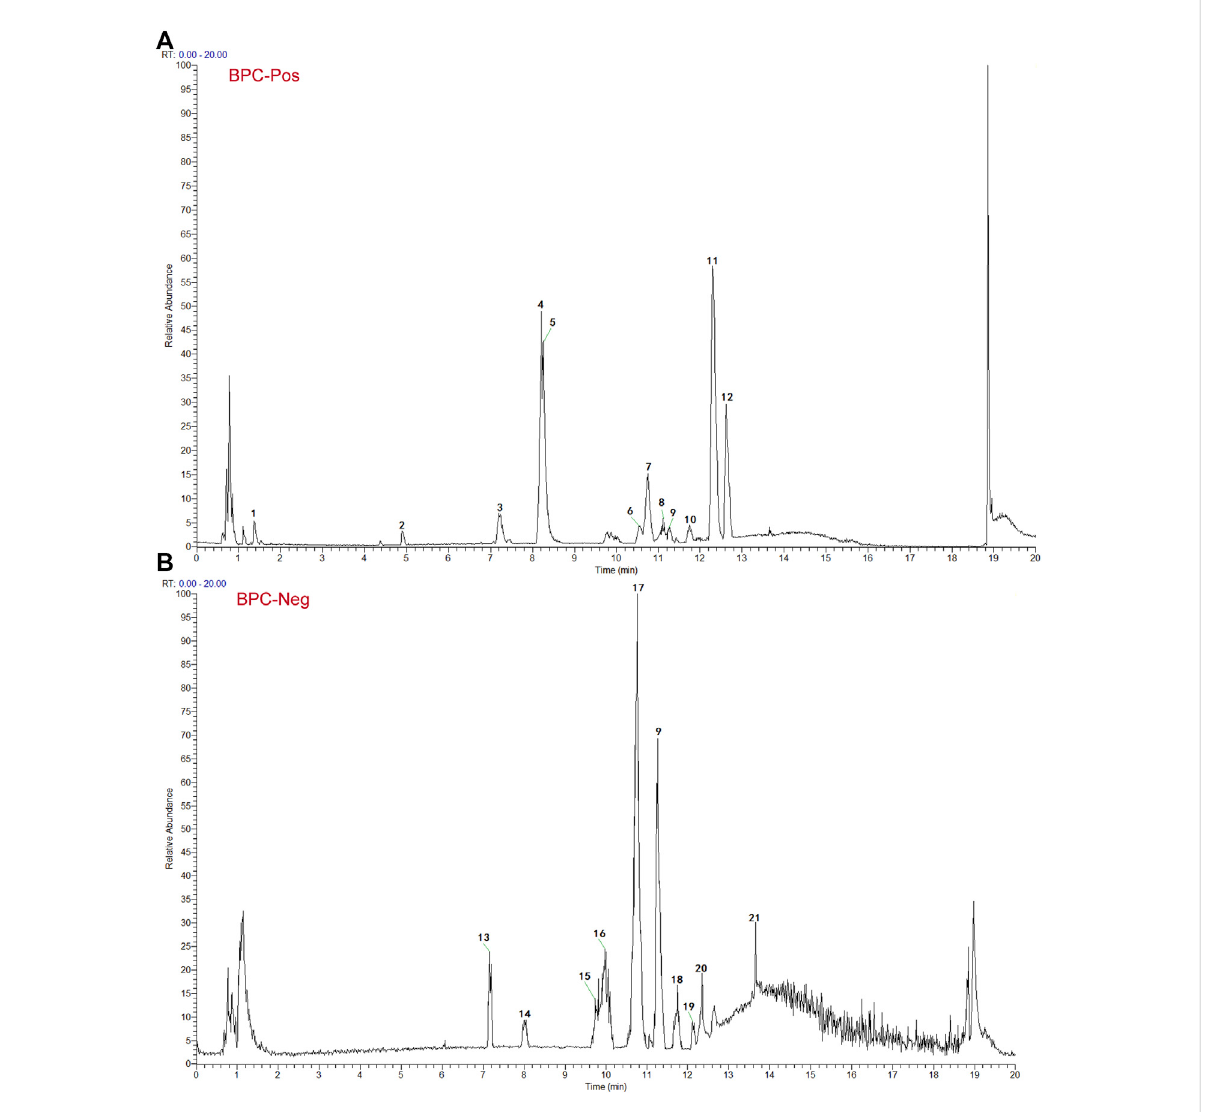
FIGURE 2 Identi fi cationresultsofthemainchemicalcomponentsofZZObyUPLC-Q-HRMS. (A) Totalion fl owdiagramofZZOinnegativemode. (B) Total ion fl ow diagram of ZZO in positive ion